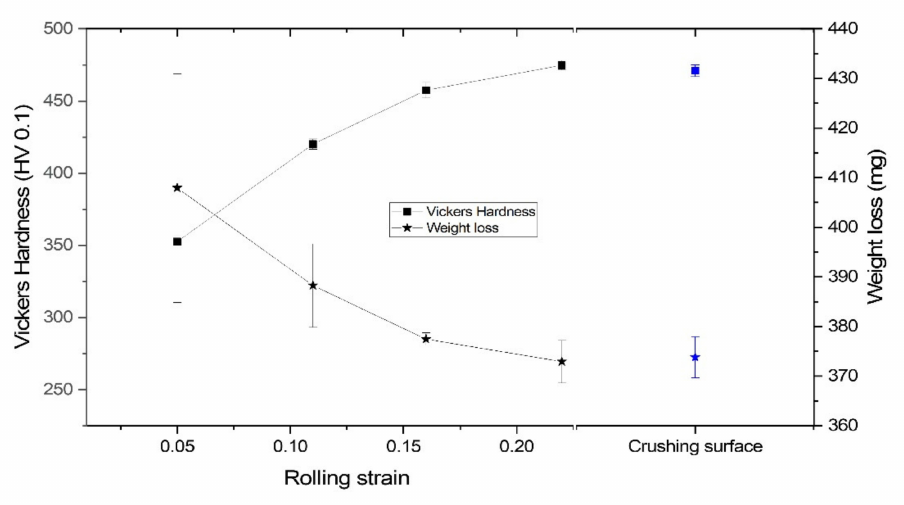
Figure 7. Relationship between rolling strain vs. hardness and weight loss (according to ASTM G65) in a Hadfield